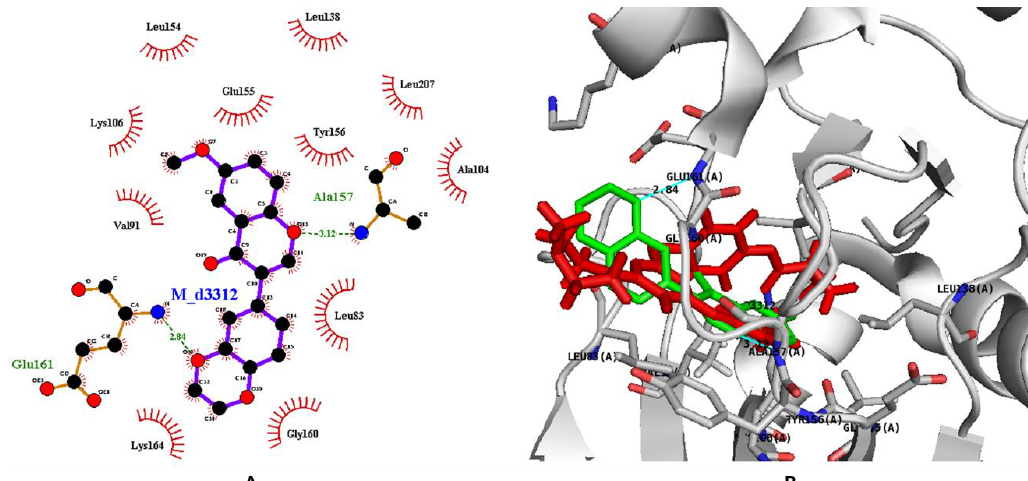
Figure 11. ( A ) The residues participating in the binding sites of the isoflavone 6 –AURKB complex analyzed by using the LigPlot program. ( B ) Three-dimensional image of the Aurora kinase B and isoflavone 6 complex, where isoflavone 6 is colored in green and the original ligand VX680 contained in 3uod.pdb is colored in red.